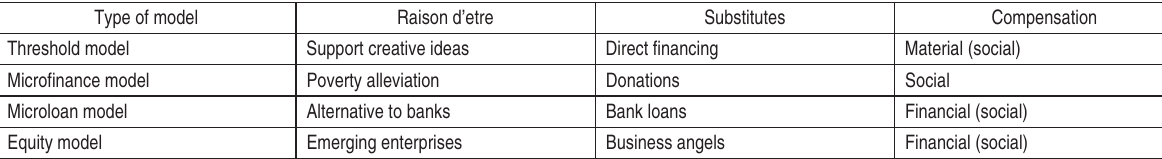
Table 2. Types of crowdfunding